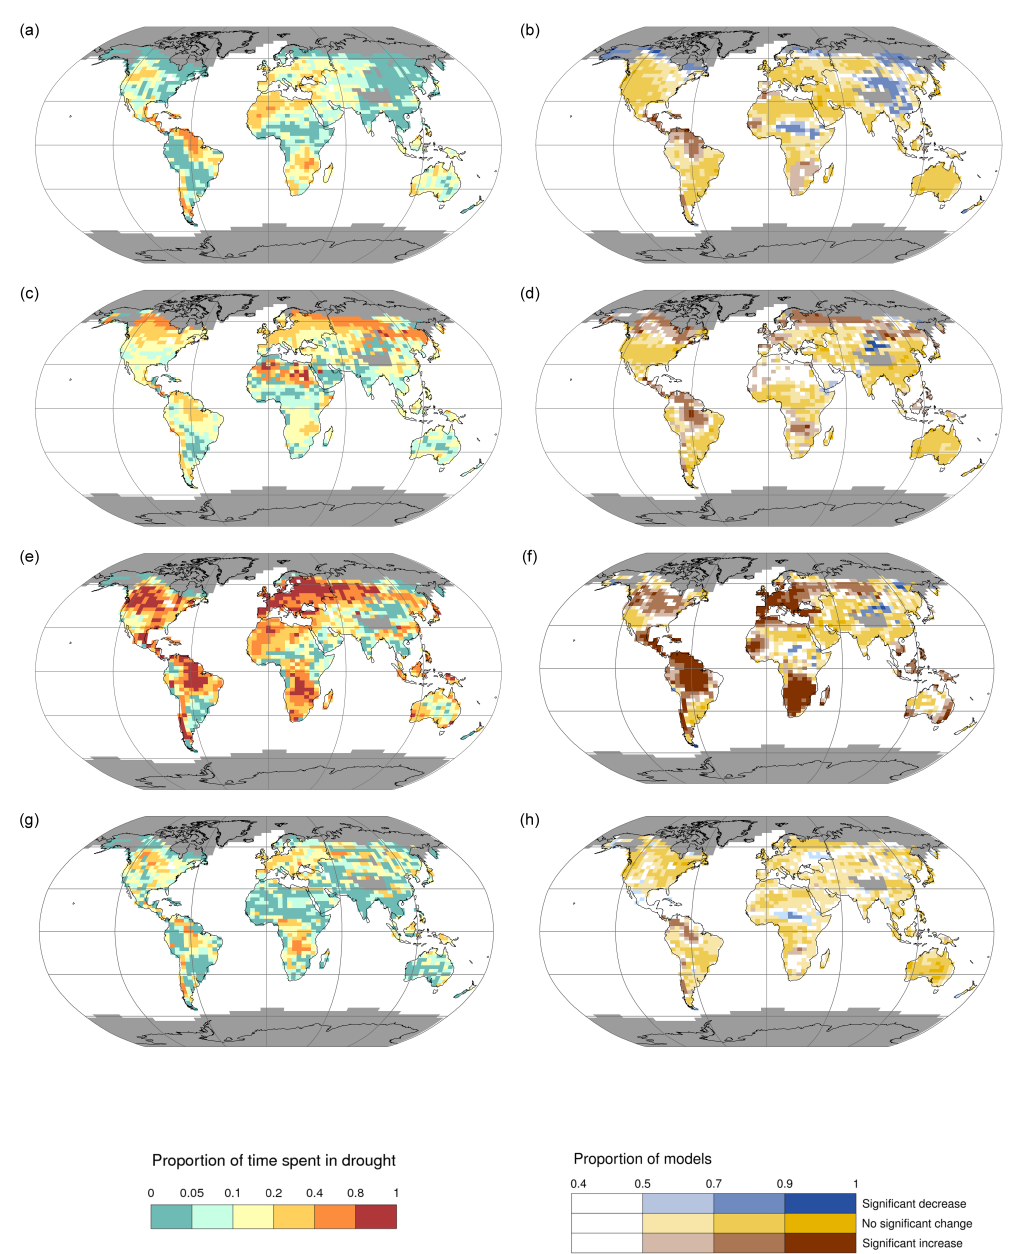
Fig. 6. The proportion of time spent in drought for three drought indices from the ESE for the RCP2.6 future scenario in the 2080s (2070– 2099), exemplar model (left panels) and model agreement of significant changes (right panels). (a) and (b) are the SPI, (c) and (d) are for the SMA; (e) and (f) are for the PDSI; and (g) and (h) are for the SRI. Grey areas represent the excluded cold regions. Results shown are for the 10th percentile calculations